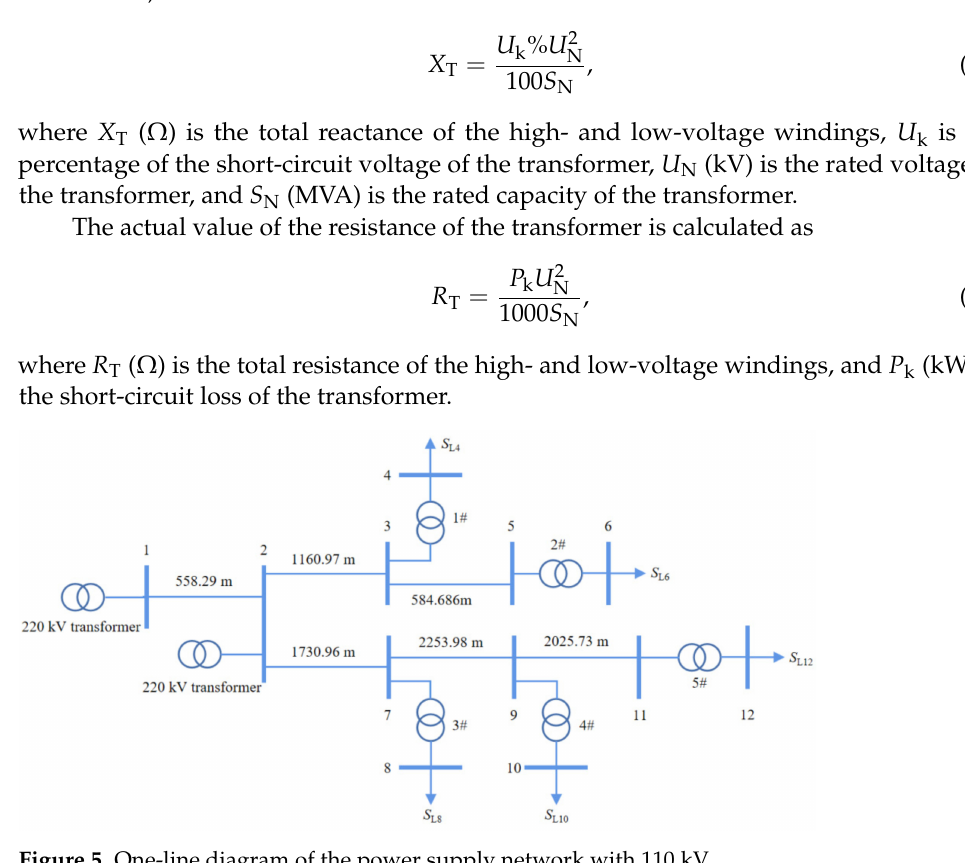
63 MVA are indicated in Table